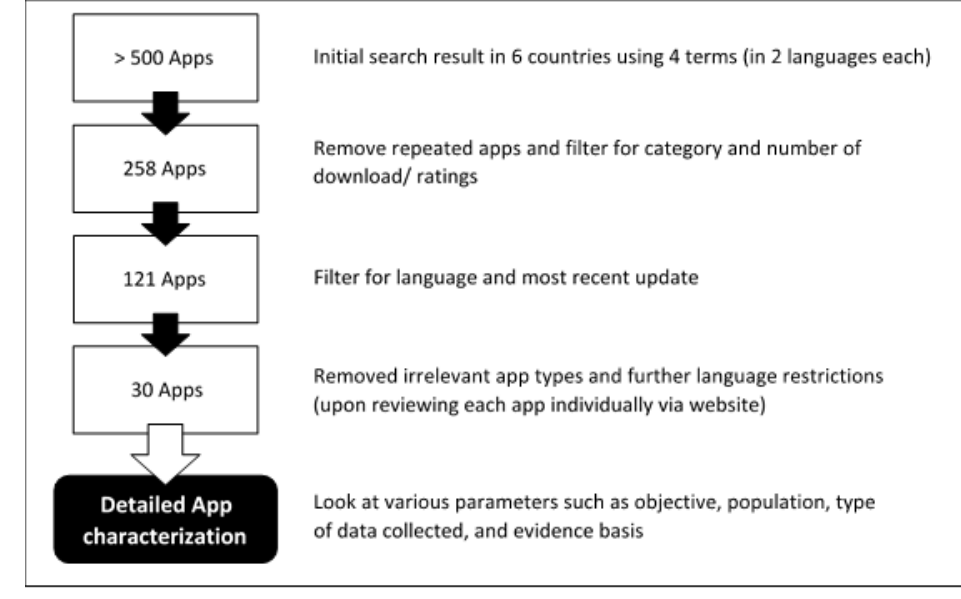
Figure 2. Flowchart of apps within the search.